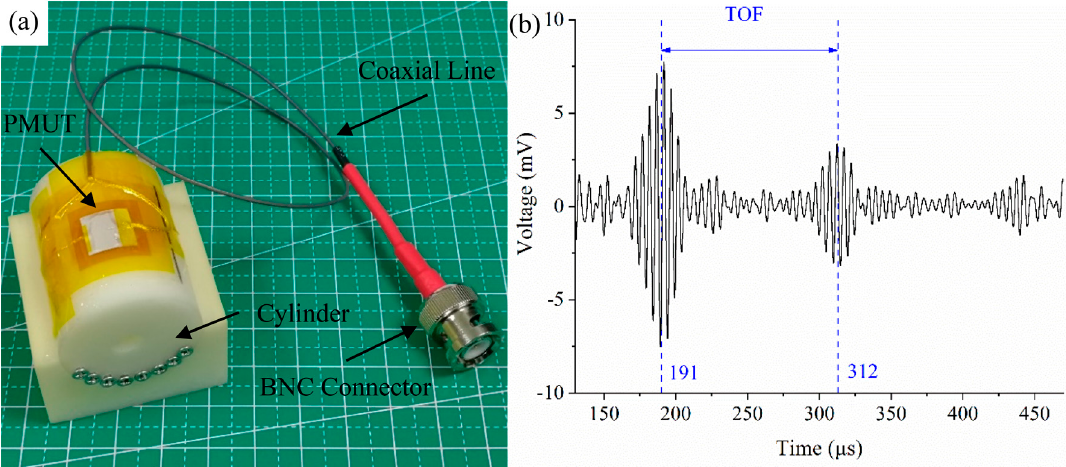
Figure 18. ( a ) PMUT mounted on a cylinder with 30 mm curvature radius. ( b ) Time of flight (TOF) measurement using PMUT on curved surface.